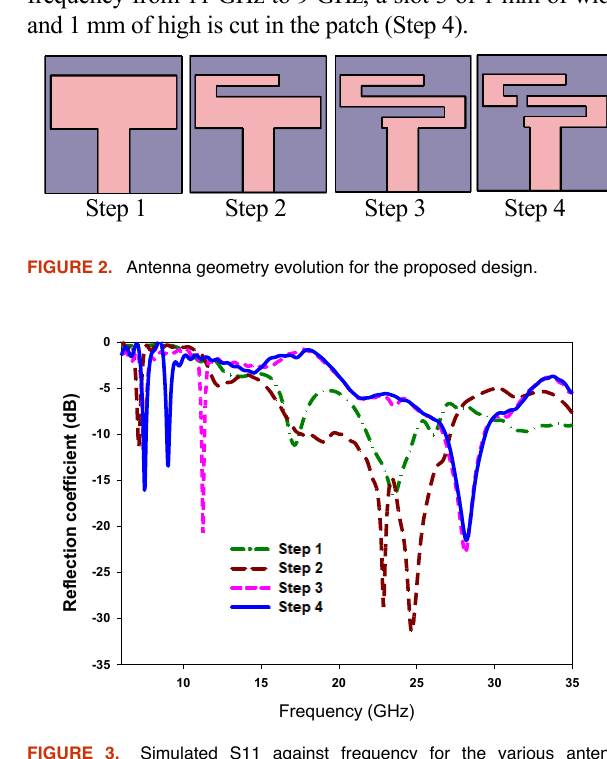
FIGURE 3. Simulated S11 against frequency for the various antenna